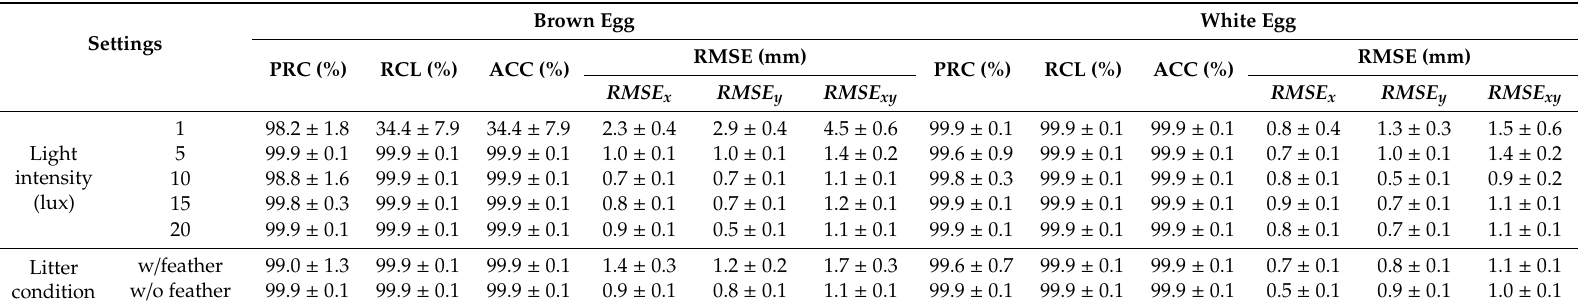
Table 5. Performance (mean ± standard deviation) of the faster region-based convolutional neural network (faster R-CNN) floor-egg detector on floor egg detection under di ff erent environmental settings using average 40 images of each level of the settings in each of the five events.